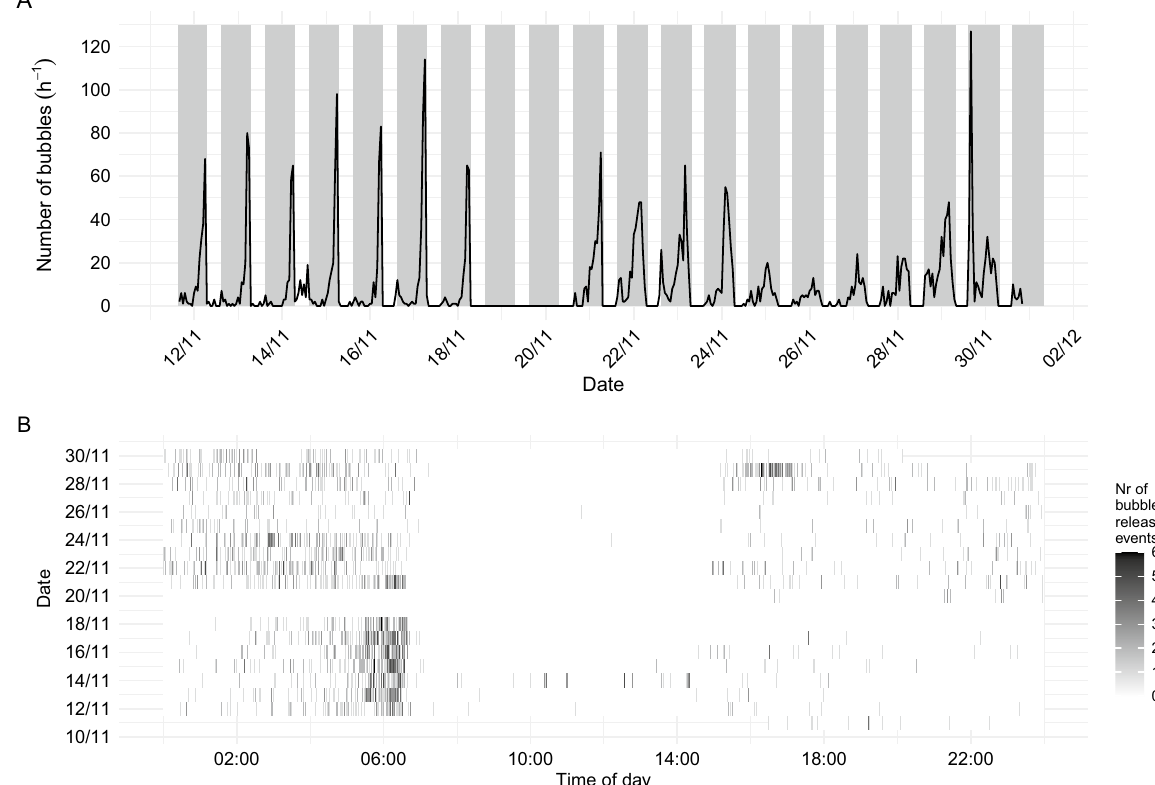
Figure 1. ( A ) Daily patterns of gas release, with shaded areas representing night. ( B ) Release events per minute over the course of a day. Data are not available on 19 and 20 November due to instrument